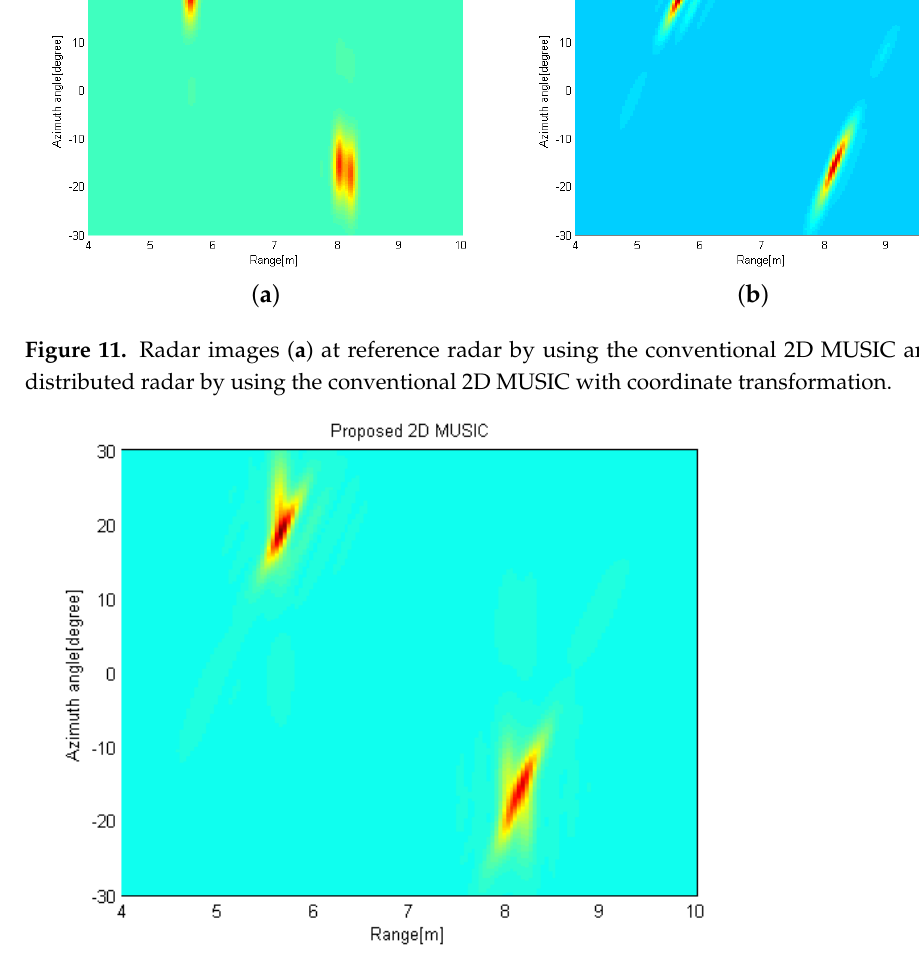
Figure 12. Radar image by using the proposed 2D MUSIC algorithm with coordinate